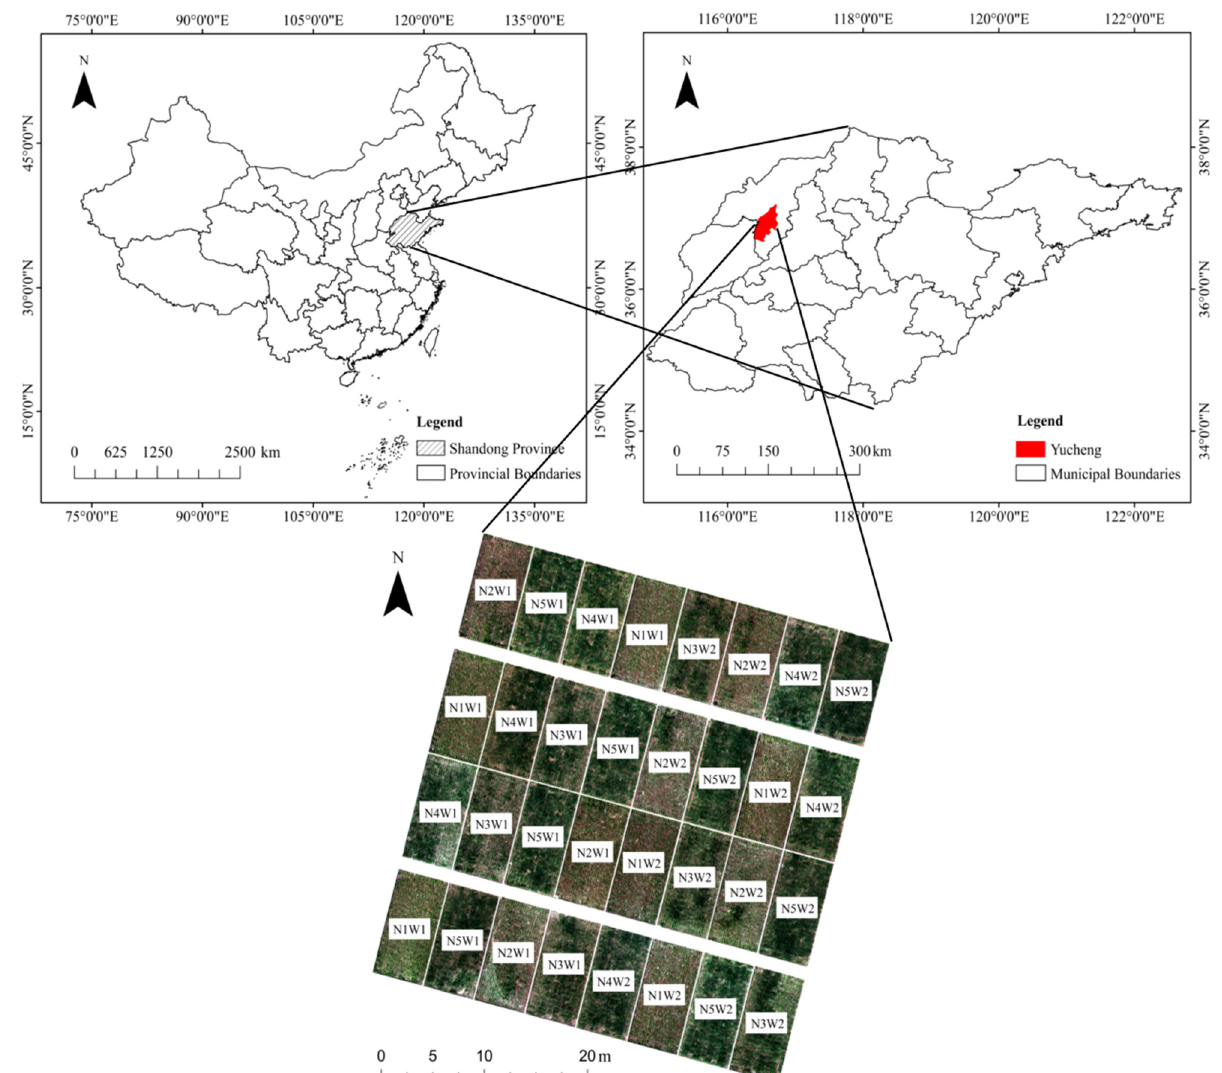
Figure 1. Field trial design (W1: 80% field capacity; W2: 60% field capacity; N1: 0 kg N/ha − 1 ; N2: 70 kg N/ha − 1 ; N3: 140 kg N/ha − 1 ; N4: 210 kg N/ha − 1 ; N5: 280 kg N/ha − 1 ).